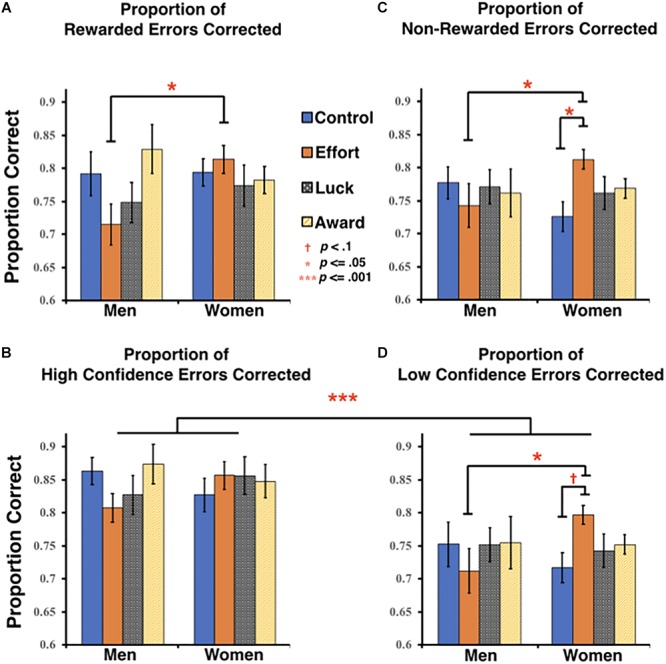
Trial-level analyses of error correction. Proportion of errors corrected on trials in which (A) a reward was received and (B) no reward was received (non-rewarded errors include both reward-eligible and ineligible trials). Proportion of errors corrected for trials endorsed either with (C) high confidence or (D) low confidence. Error bars represent the standard error of the mean (SEM).